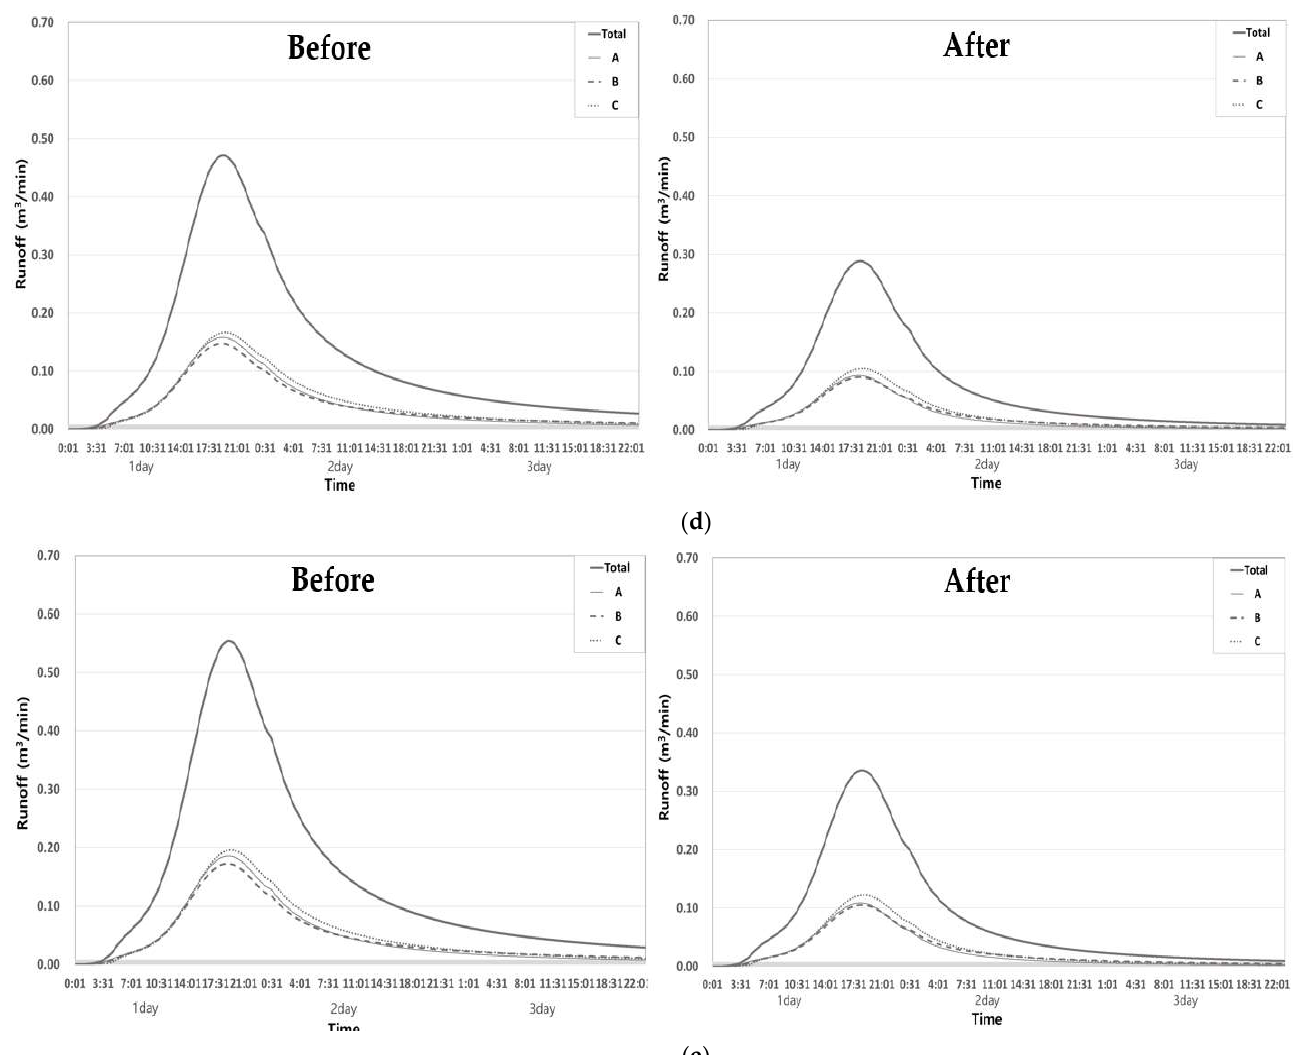
Figure 8. Runoff by return period according to LID facility installation (RCP 4.5, 1988–2100): ( a ) 10-year return period; ( b ) 20-year return period; ( c ) 50-year return period; ( d ) 100-year return period; ( e ) 200-year return period.